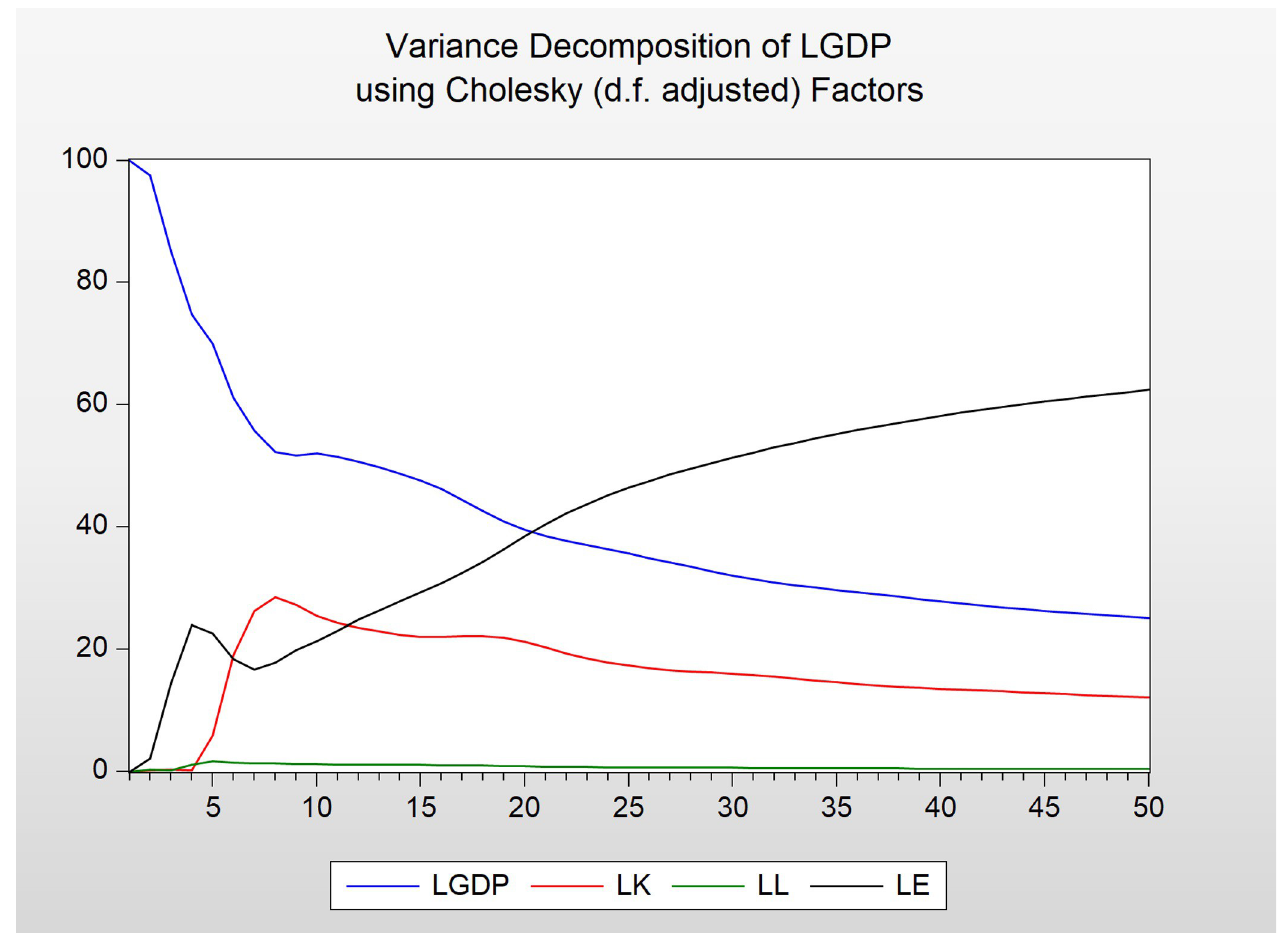
Fig 10. Variance decomposition results of